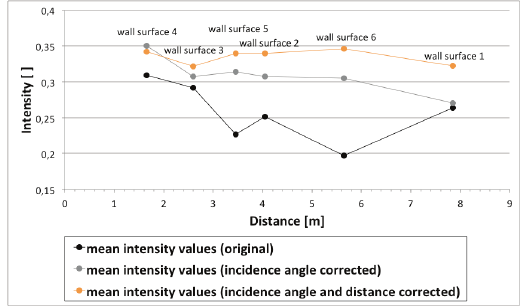
Figure 13. Intensity-distance-curves of selected wall areas after different correction steps